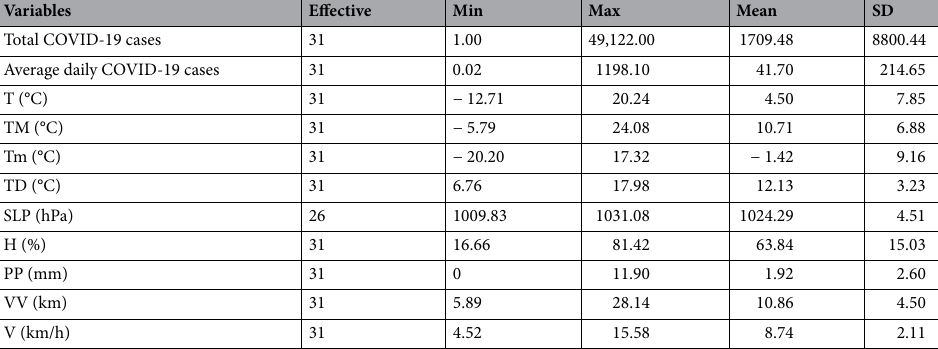
Table 1. Cumulative description of confirmed cases and meteorological factors in 31 major cities. COVID‑19 Corona Virus Disease 2019, Min minimum, Max maximum, SD standard deviance, T average temperature, TM maximum temperature, Tm minimum temperature, TD diurnal temperature variation, SLP atmospheric pressure at sea level, H relative humidity, PP total precipitation, VV average visibility, V average wind speed.